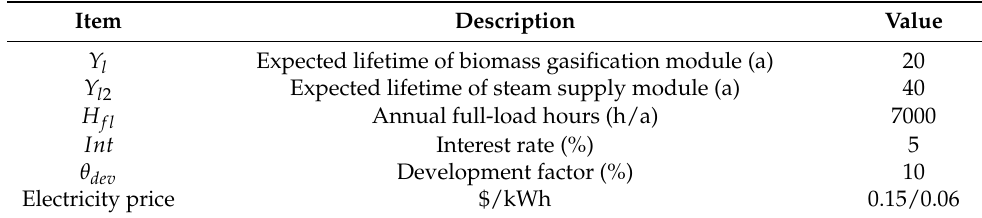
Table 3. Values of parameters for economic evaluation.